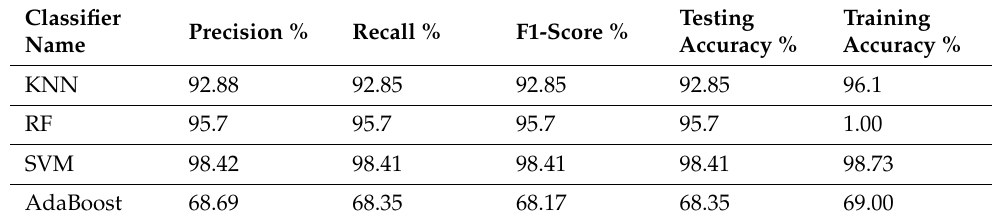
Table 2. Testing results of the proposed machine-learning models using traditional data splitting.